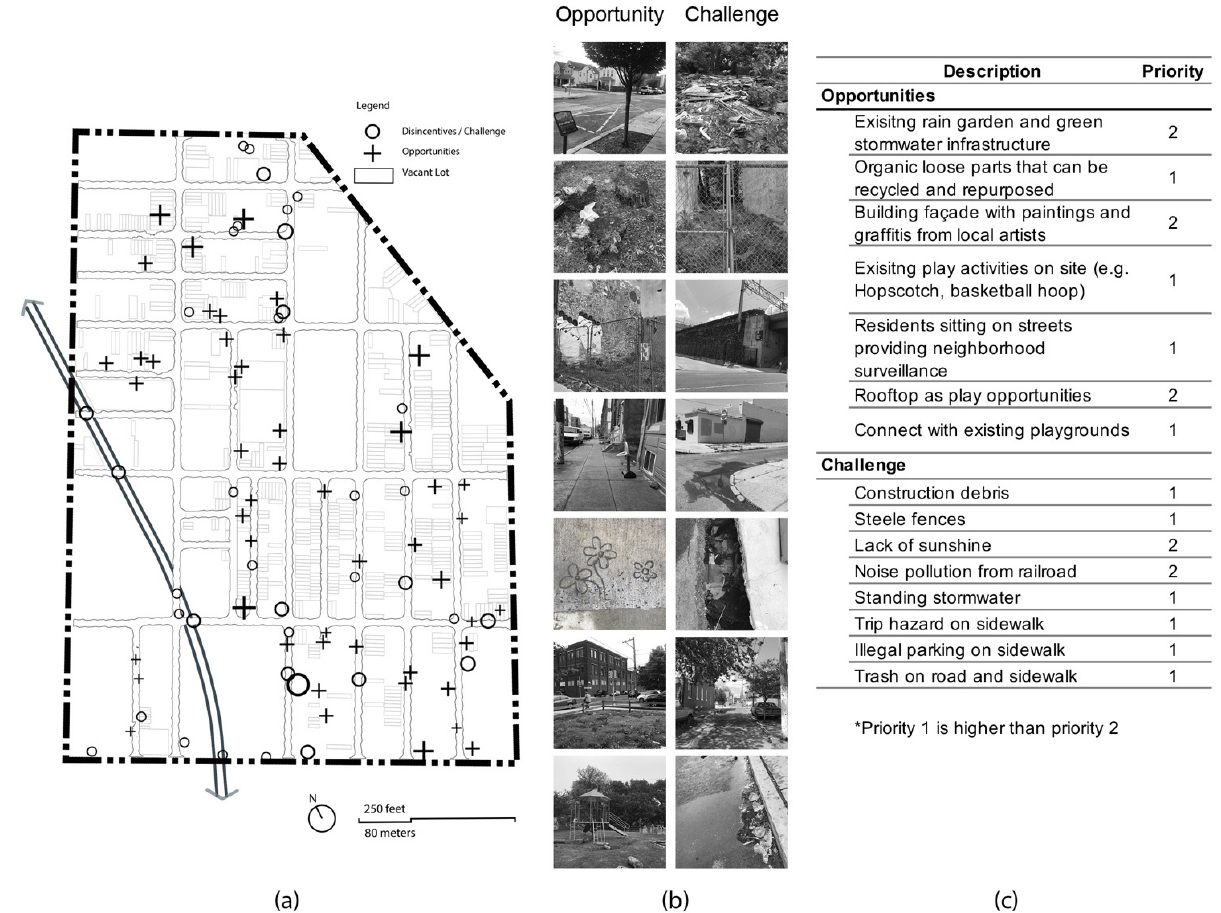
Figure 6. ( a ) Observation and Tacit Experiences map; ( b ) Examples of opportunities and challenges captured by photos; ( c ) synthesis priority table.